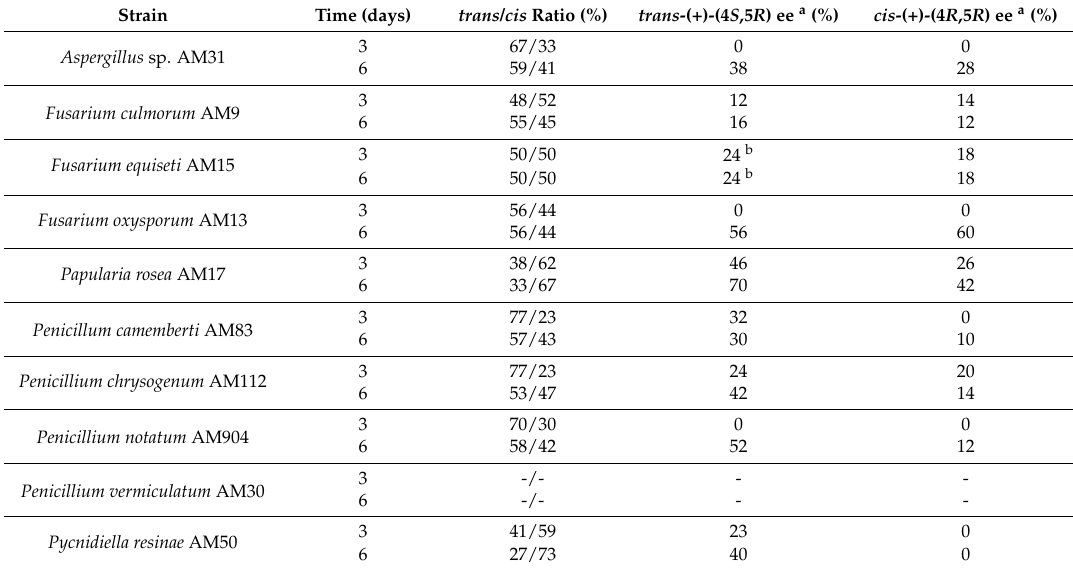
Table 1. Composition of isomers of whisky lactone after microbial kinetic resolution of diastereoisomeric mixture of whisky lactone (in % according to GC).